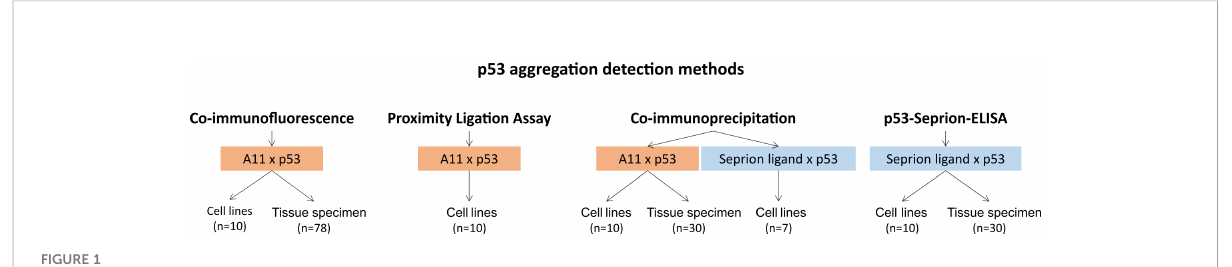
FIGURE 1 Overview of the p53 aggregation detection methods evaluated in this